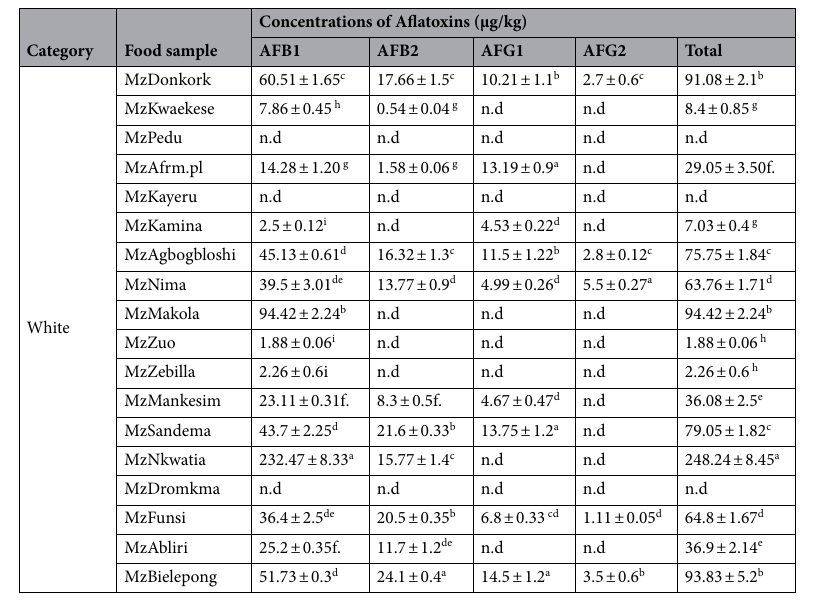
Table 5. Concentration of aflatoxin types in different maize samples from different locations of Ghana. Mean ± Standard Deviation that do not share a letter are significantly different (p > 0.05). n.d not detected.